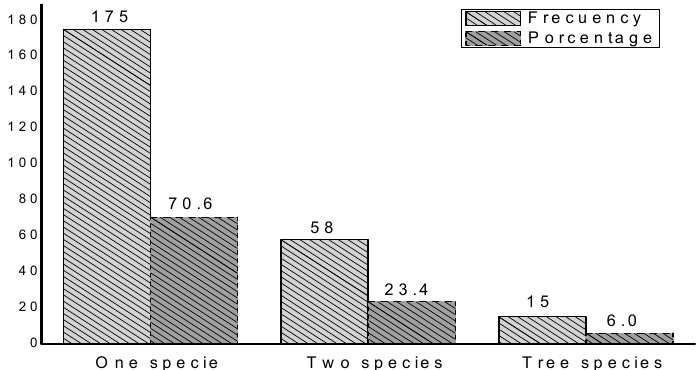
Figure 6. Aquaculture producers surveyed in Mexico. Polyculture practice of aquatic species (2019).